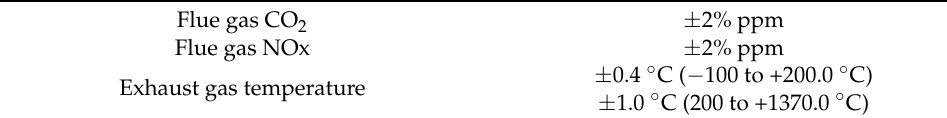
Table 5. Accuracy of exhaust gas